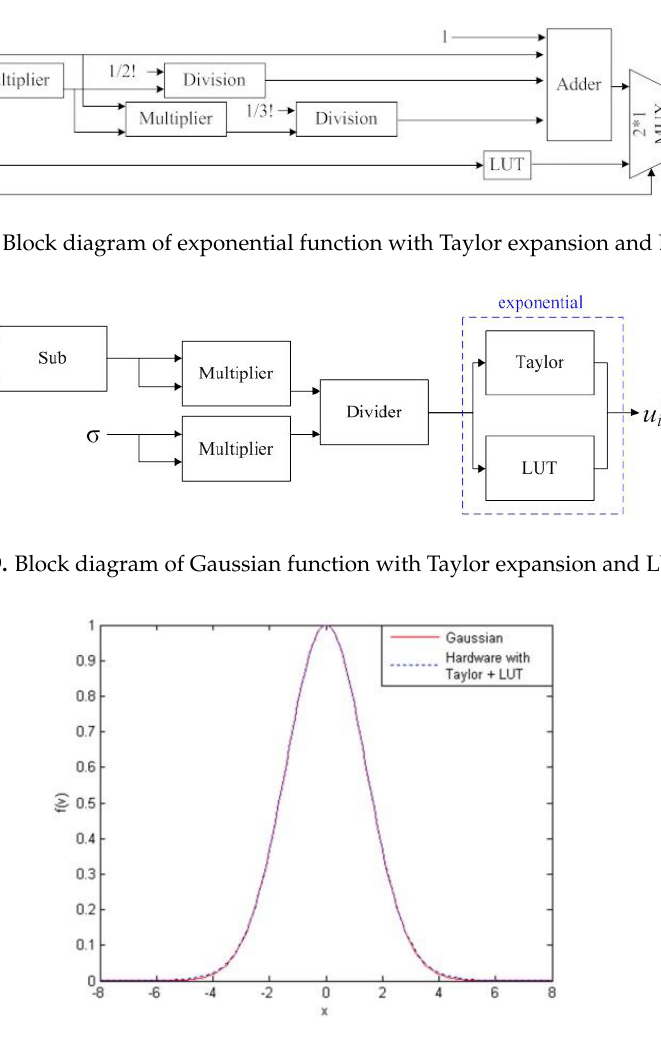
Figure 10. Taylor and LUT approximation of a Gaussian function.